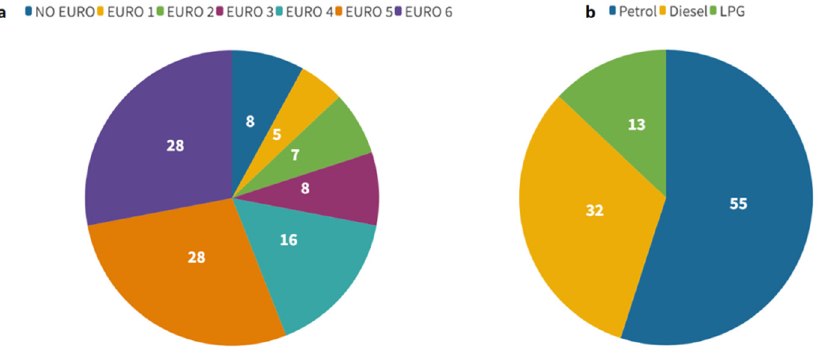
Table 3. The data for passenger cars of the P&R sites. No. Number of Vehicles Average Estimated Distance Traveled by Drivers (km) Parking 1 26,006 10.0 Parking 2 14,235 22.4 Parking 3 32,205 13.0 Parking 4 2872 14.0 The assumed emission standards and fuel parameters of the vehicles analysed in the COPERT calculator are presented in Figure 5.